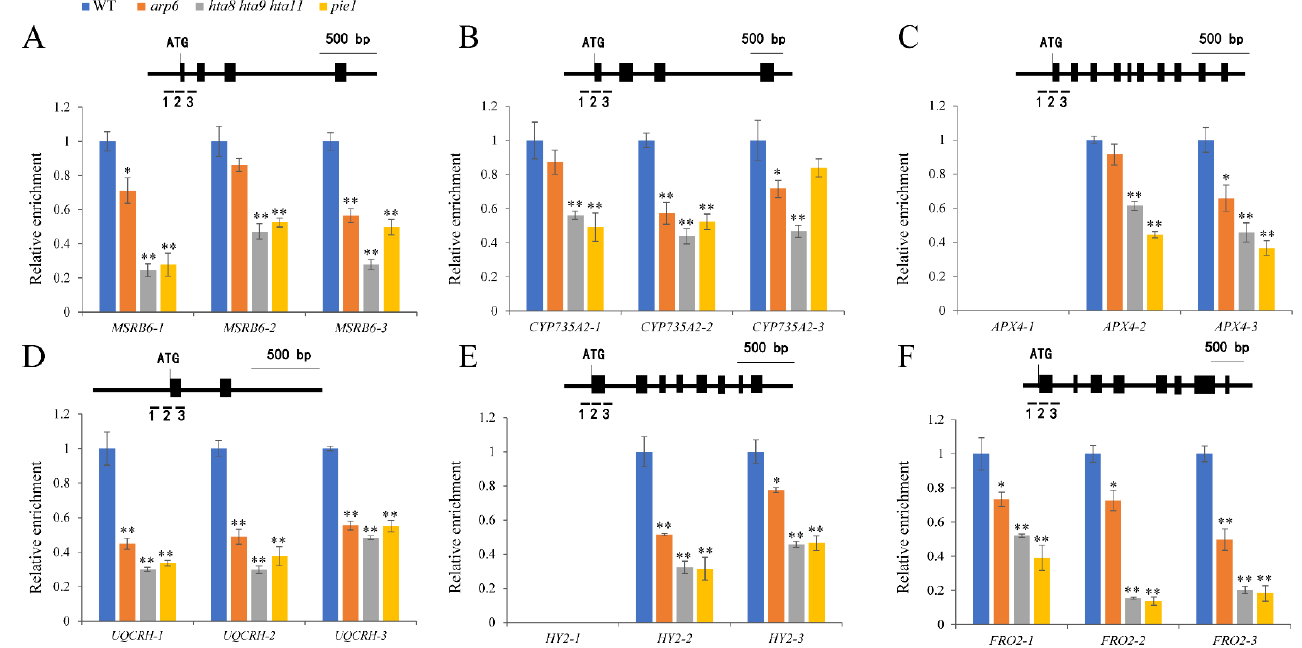
Figure 5. H2A.Z deposition in oxidoreductase activity-related genes was altered in the roots of arp6 , hta8 hta9 hta11 , and pie1 : ( A – F ) ChIP-qPCR analysis of H2A.Z deposition at MSRB6 , CYP735A2 , APX4 , UQCRH , HY2 , and FRO2 genes in WT roots, arp6 , hta8 hta9 hta11 , and pie1 . The exons are indicated by black boxes and the promoter by the region before the ATG indicator. The transcription start site (TSS) is represented by a black indicator line. PCR primer sets are represented by black bars below the diagram. Error bars indicate ± SD ( n = 3 replicates). Asterisks above the columns indicate statistically significant differences (* p < 0.05, ** p < 0.01) determined by Student’s t test.